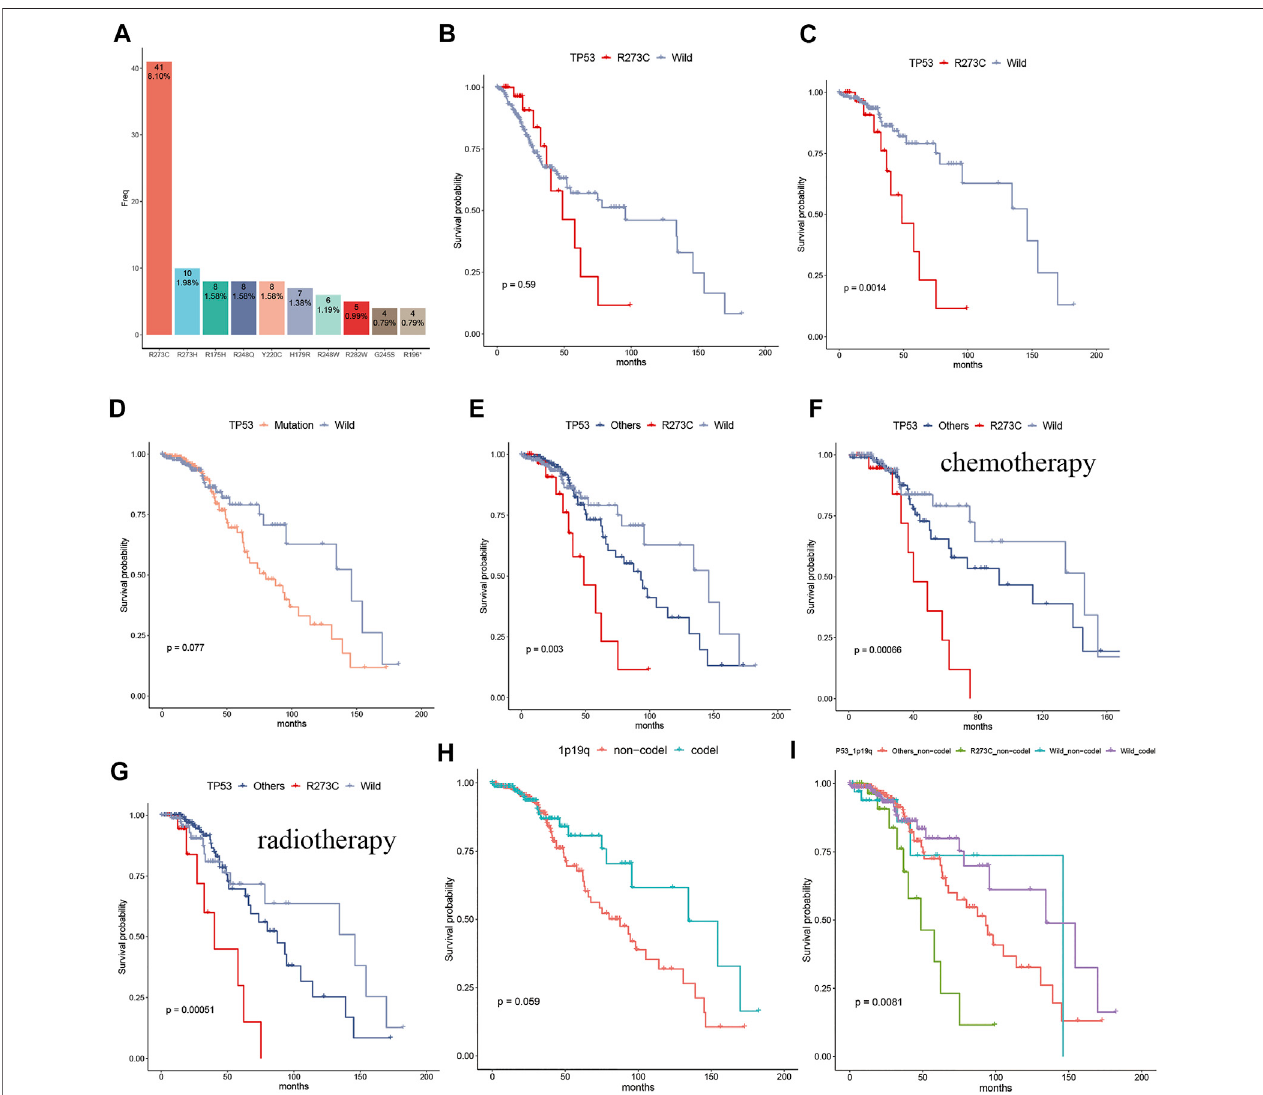
FIGURE 2 | The frequency of the TP53 R273C mutant and its prognostic signi fi cance in LGG patients. (A) The bar plot showed the frequency of TP53 hotspot mutation in LGGs, and the R273C mutant had the highest mutation frequency, according for 8.1% in the whole LGGs. (B) Comparison of survival of the R273C ( n = 32) and the TP53 wild groups ( n = 269) in the whole LGG patients. (C – I) Comparison of survival in the LGG patients with IDH1/2 mutation. (C) R273C ( n = 32) mutation vs. wild( n =189). (D) mutation( n =212)vs.wild( n =189). (E) R273C( n =32)vs.others( n =180)vs.wild( n =189). (F) R273C( n =22)vs.others( n =96)vs.wild( n =96) in patients who received chemotherapy. (G) R273C ( n = 22) vs. others ( n = 119) vs. wild ( n = 79) in patients who received radiotherapy. (H) 1p19q codel ( n = 155) vs. 1p19q non-codel ( n = 245). (I) others_non-codel ( n = 175) vs. R273C non-codel ( n = 31) vs. wild codel ( n = 150) vs. wild non-codel ( n = 39).